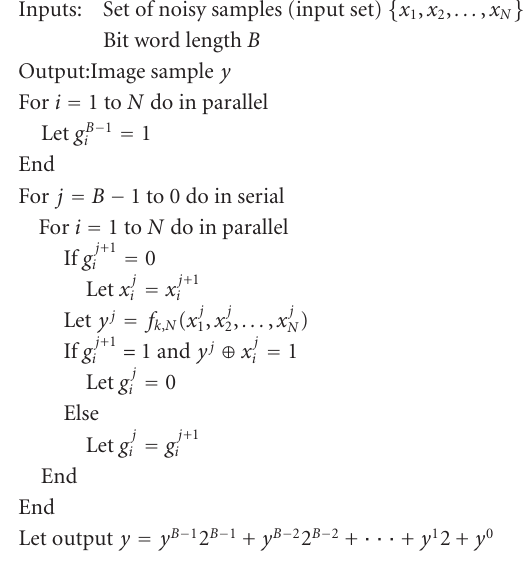
Algorithm 2: Algorithm of the pipelined bit-serial realization of the PBF-based LUM